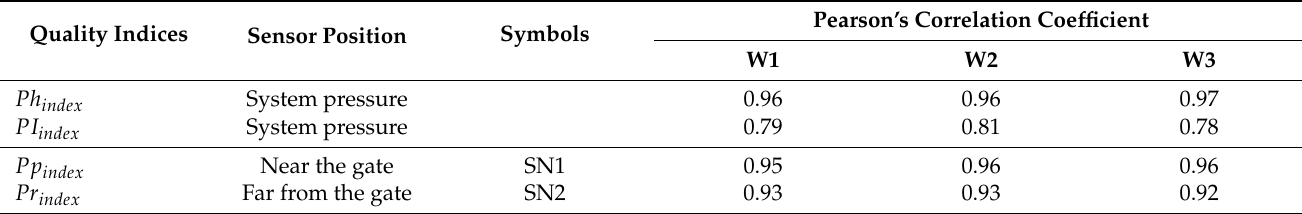
Table 2. Pearson correlation coefficients (PCCs) between geometric widths and quality indices.